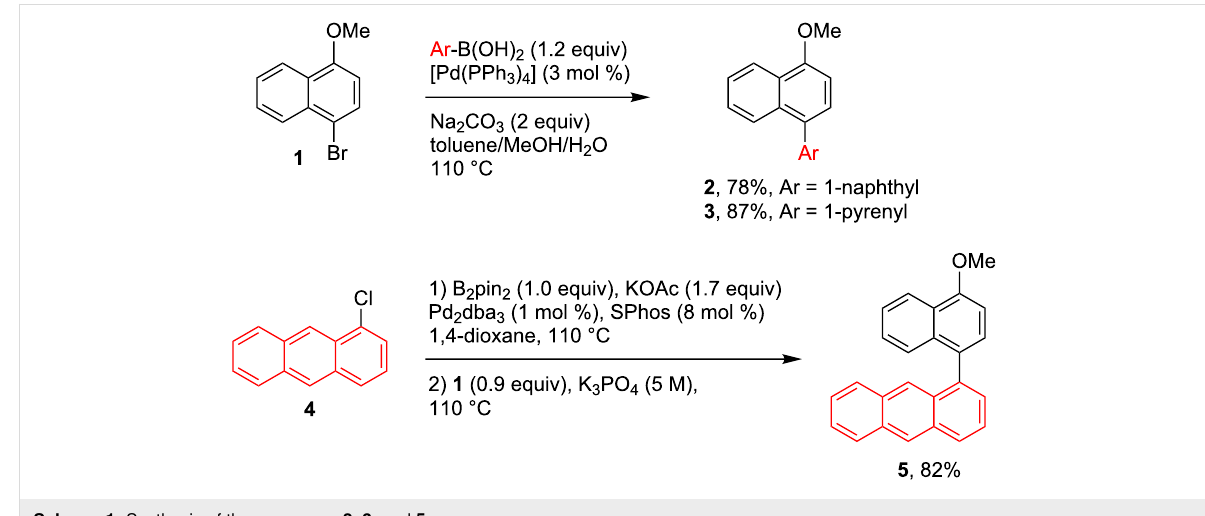
Scheme 1: Synthesis of the precursors 2 , 3 , and 5 .